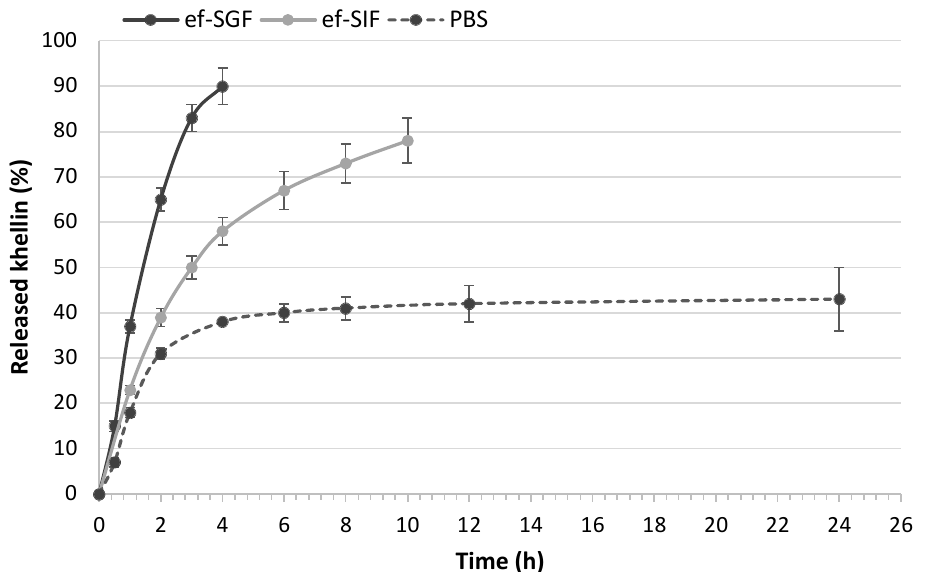
Figure 6. Release study of khellin from K-NLCs in different media: PBS, ef-SGF (enzyme-free simulated gastric fluid), and ef-SIF (enzyme-free simulated intestinal fluid). Data are expressed as media ± standard deviation ( n = 3).